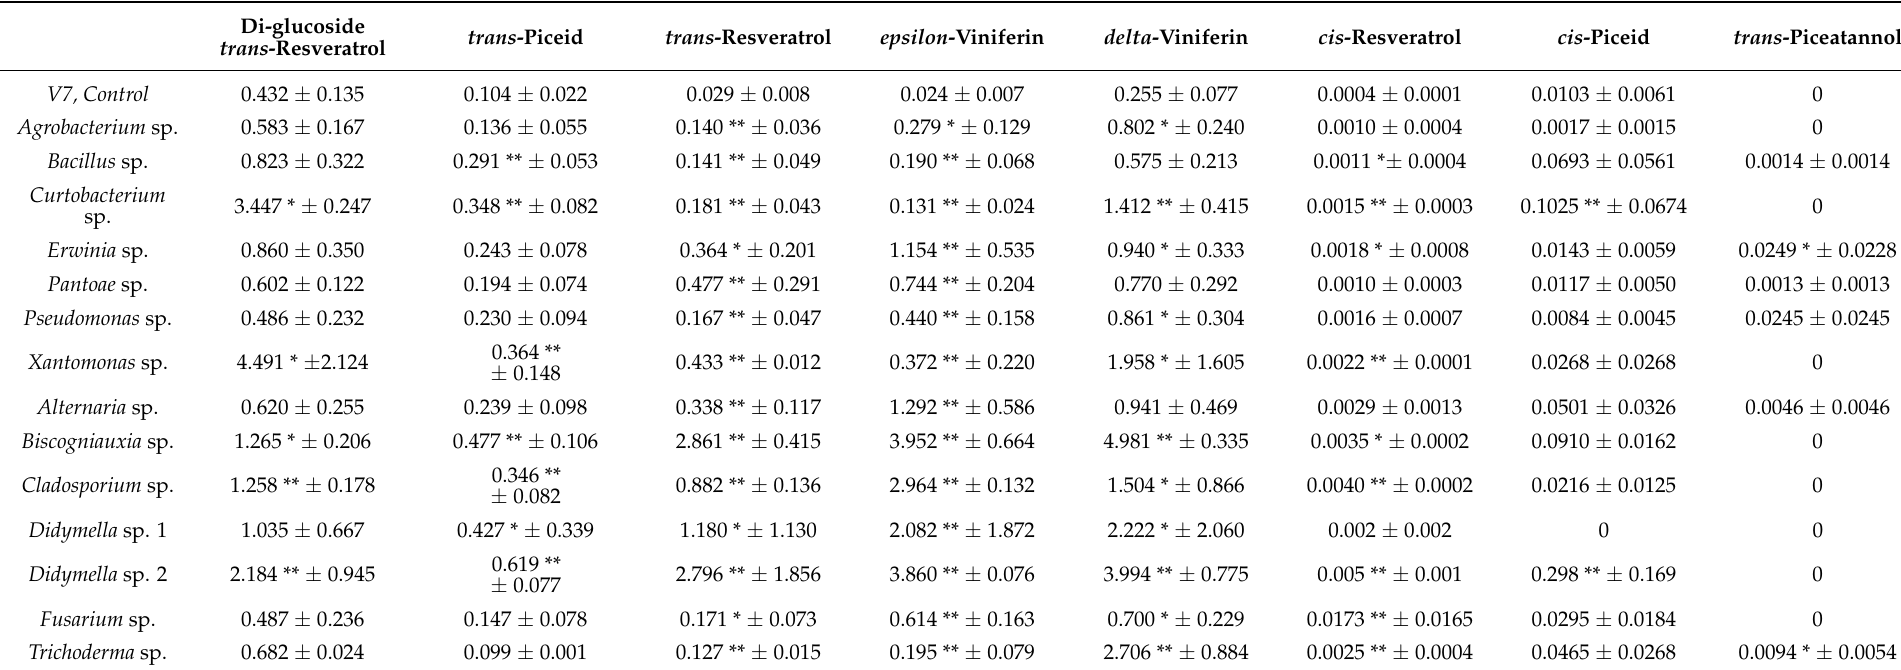
Table 2. The content of stilbenes in the Vitis amurensis cell culture V7 after 3 days of cocultivation with endophytic bacteria or fungi, mg/g DW. * p < 0.05; ** p < 0.01 versus values of stilbene accumulation in the V7 cell cultivated under control conditions without bacteria and fungi.